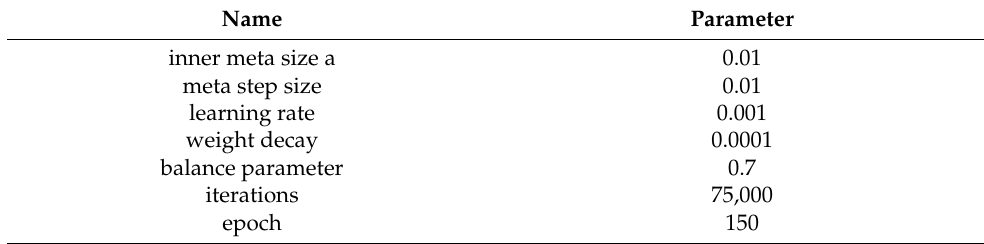
Table 1. Hyperparameter settings in our